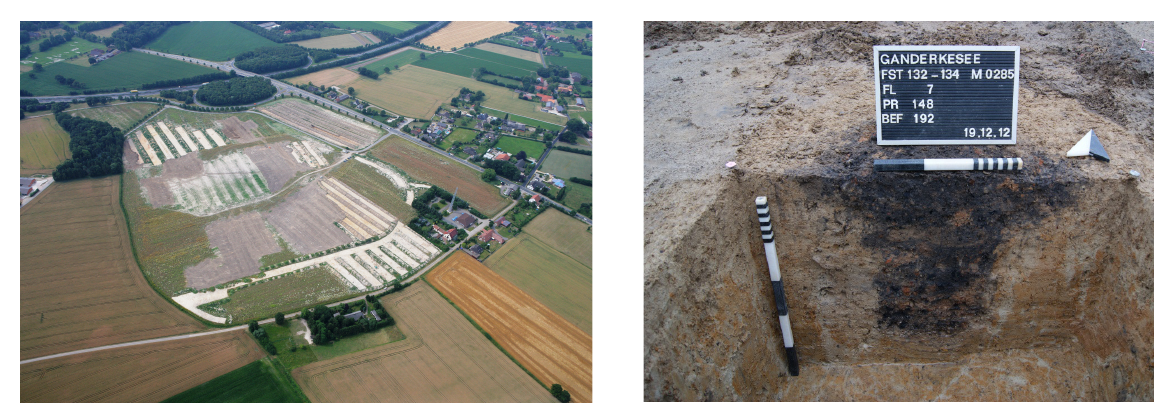
Figure 9: Aerial view of the excavation site in Ganderkesse, Ger- many.